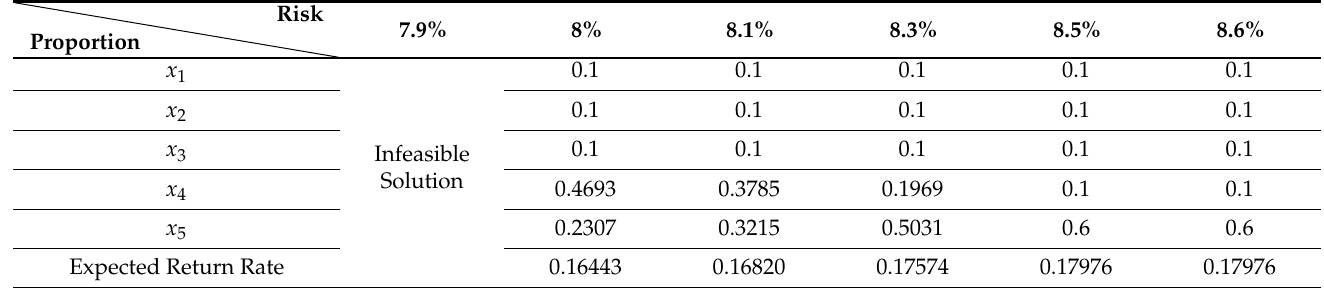
Table 11. The efficient portfolio with s = 4 in a guaranteed return rate (cid:101) p 2 .